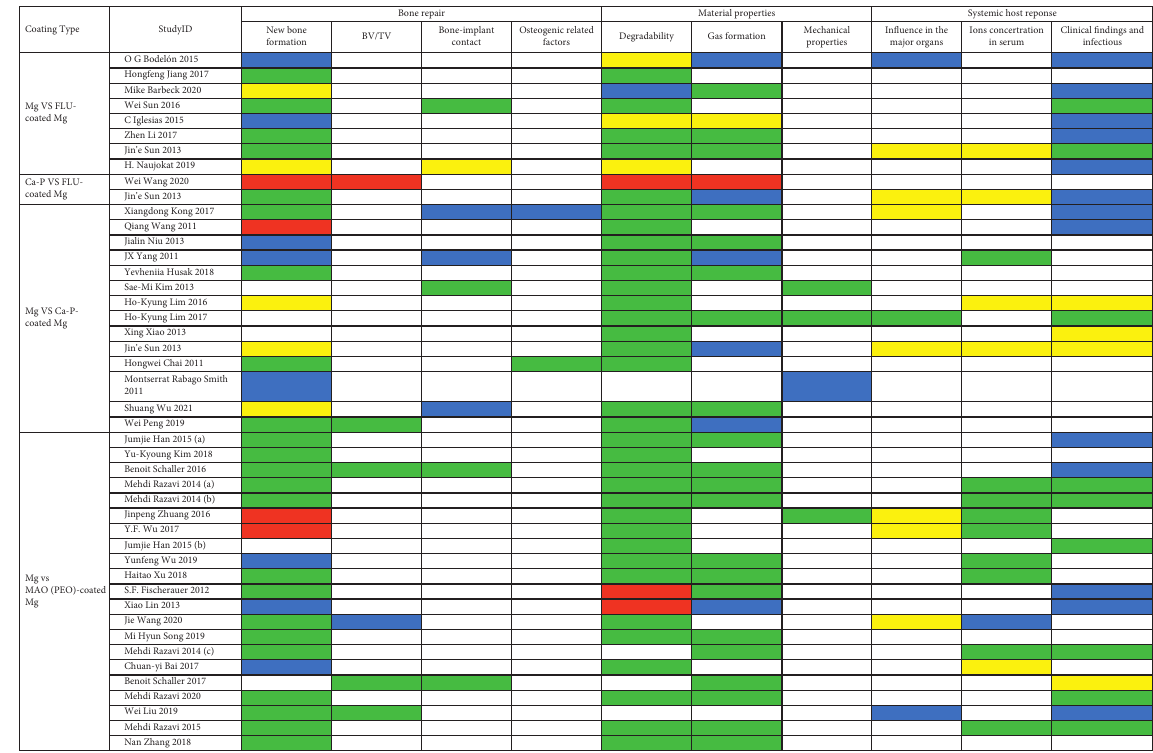
Figure 6: Results of the qualitative analysis. (red, control group > experimental group; green, experimental group > control group; yellow, there is no significant difference between the two groups; blue, there is no comparison between the two groups or the result of one group was solely